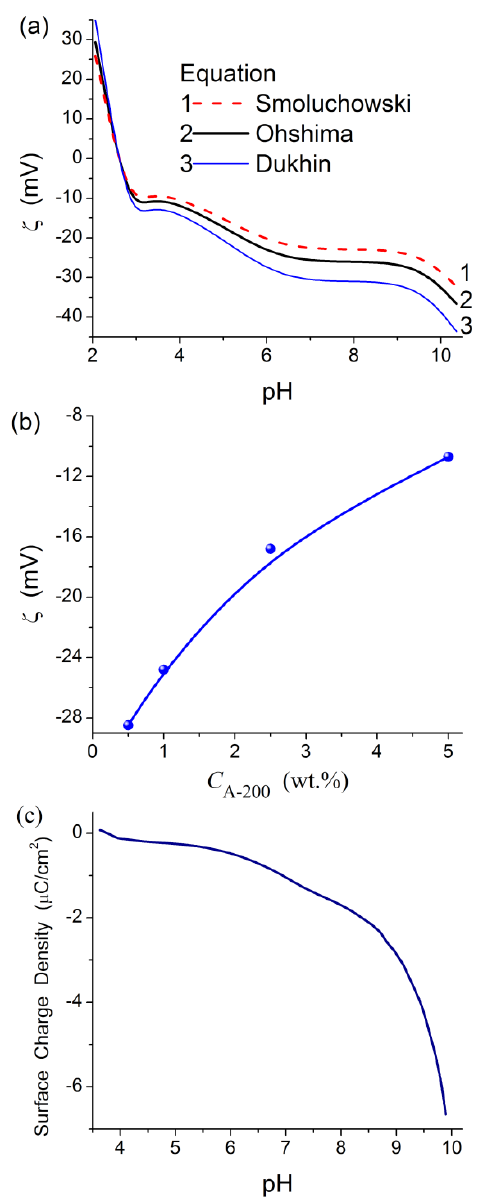
Figure 4. Zeta potential as a function of (a) pH and calculated using Smoluchowski (with the Henry correction factor close to IEP) (curve 1), Ohshima (2), and Dukhin (3) equations for diluted suspension at 0.02 wt.% of silica and 0.01M NaCl; and (b) A-200 content in the aqueous suspension without addition of any electrolyte; and (c) surface charge density of nanosilica (0.2 wt.%, 0.001M NaCl) vs .